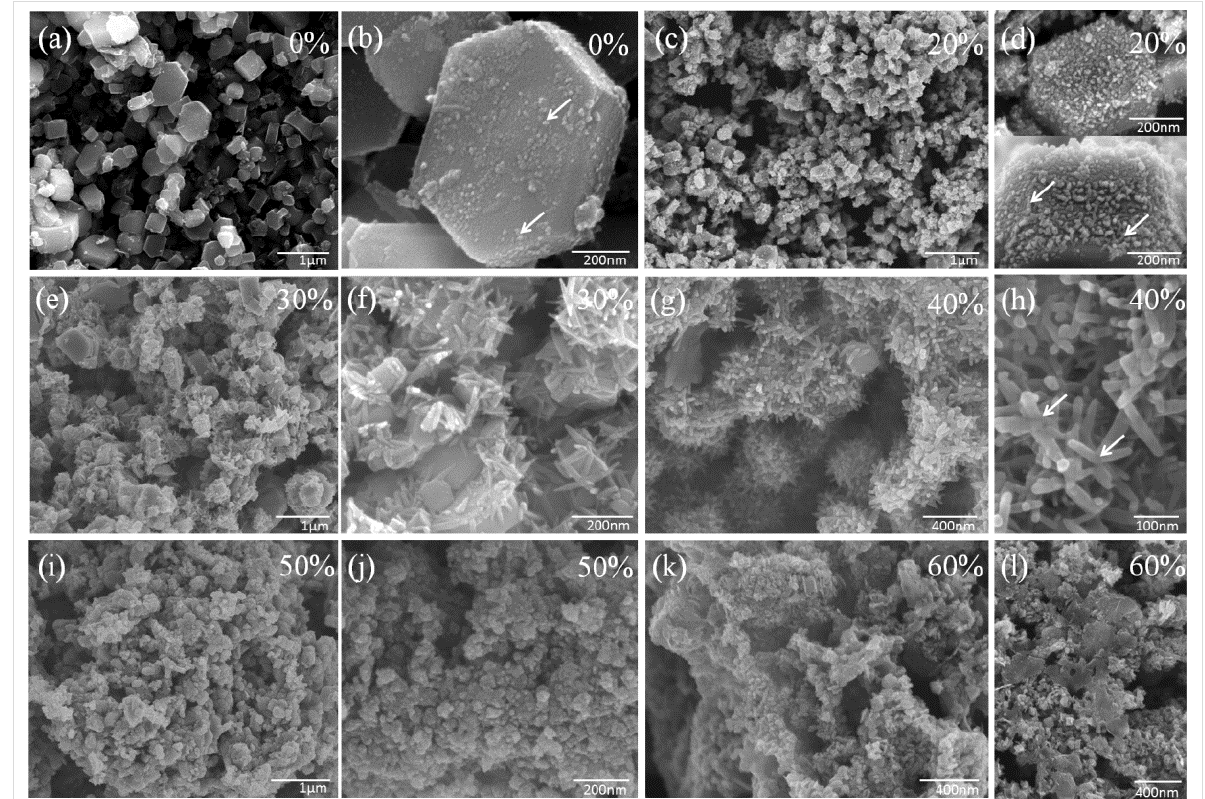
Figure 3: Typical FSEM images of the as-synthesized TiB 2 /(TiB 2 –TiN) samples with different endothermic rates (a,b) 0%; (c,d) 20%; (e,f) 30%; (g, h) 40%; (h,i) 50%; (j,k) 60%. Scale bars: (a) 1 μ m, (b) 200 nm, (c) 1 μ m, (d) 200 nm, (e) 1 μ m, (f) 200 nm, (g) 400 nm, (h) 100 nm, (i) 1 μ m, (j) 200 nm, (k) 400 nm and (l) 400